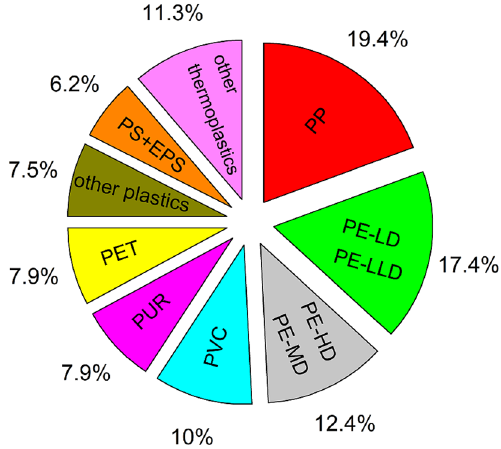
Fig. 1 Distribution of global plastic production in 2019, by type; PP-Polypropylene; PE-Polyethylene; PVC-Polyvinyl chloride; PUR- Polyurethane; PET-Polyethylene terephthalate; other plastics: ABS- Acrylonitrile butadiene styrene; PBT-Polybutylene terephthalate; PC-Polycarbonate; PMMA-Polymethyl methacrylate; PTFE-Polyte- trafluoroethylene; PS + EPS-PolyStyrene + Expanded PolyStyrene [3],